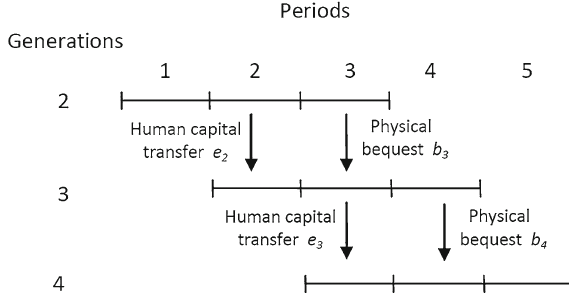
Fig. 3 Transfers within a family. (Source: Alonso-Carrera et al.